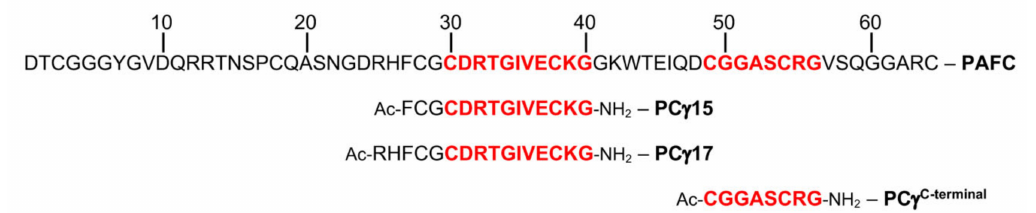
Figure 7. The primary structure of PAFC and the derived synthetic γ -core peptides. The aa sequence of PAFC is indicated by a one-letter code. The predicted levomeric γ -core motifs in the center and the C-terminus are highlighted in red. Below, sequences of the N-terminally acetylated (Ac-) synthetic peptides PC γ 15, PC γ 17, and PC γ C-terminal are